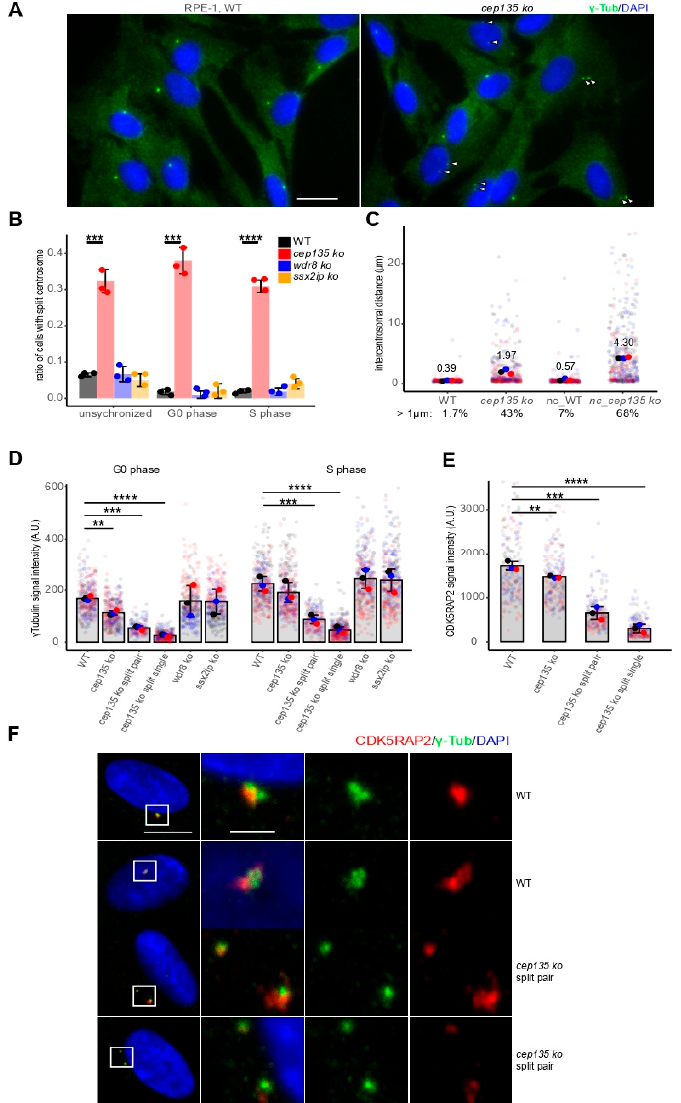
Figure 4. cep135 KO cells show premature centrosome splitting and diminished PCM. ( A ) γ -Tubulin was stained to identify cells with premature split centrosomes and reduced PCM in WT and cep135 KO cells. Scale bar: 20 μ m. ( B ) Quantification of centrosome splitting by more than 1 μ m at different cell-cycle stages in cep135 , wdr8 , and ssx2ip KO cell lines. ( C ) Quantification of centrosome distance in WT and cep135 KO cells at G 1 (48 h starvation) before and after nocodazole treatment that greatly increased centrosome distances in cep135 KO cells. ( D , E ) Quantification of the centrosomal γ -tubulin ( D ) and CDK5RAP2 ( E ) signals in WT, wdr8 , ssx2ip , and cep135 KO cells. cep135 KO cells displaying two distinct γ -tubulin signals were quantified separately either using summed intensities of both centrosomes (split-pair) or as separated values for each of the two individual centrosomes (split single). ( D ) Cells in G 0/1 and S-phase. ( E ) G 0/1 cells. ( B – E ) Graphs show mean values (fat colored/black dots) of single experiments and individual data points (transparent dots). Around 300 cells were measured for each cell line. Three independent experiments were performed. Error bars show the SD. The p -value was calculated with a two-tailed Student’s t -test. ** indicates p < 0.01, *** p < 0.005, **** p < 0.001. ( F ) Representative images showing γ -tubulin and CDK5RAP2 signals in WT and cep135 KO cells. Scale bar: 10 µ m or 2 µ m (for enlarged